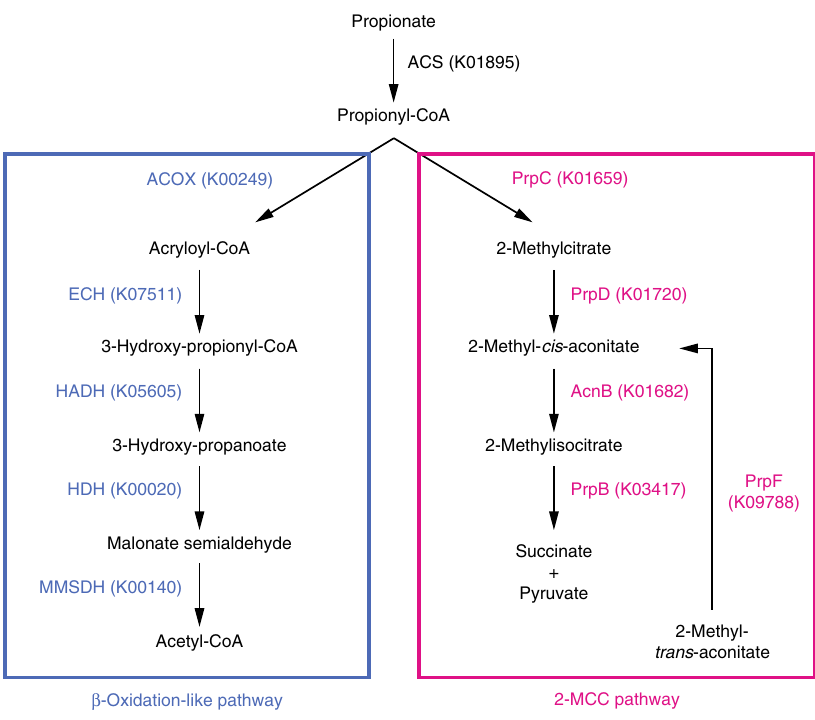
Fig. 6 Chloropicon proteins predicted to participate in the degradation of propionate via the modi fi ed β -oxidation and 2-MCC pathways. Supplementary Data 15 report the loci of the encoding genes, the presence/absence of homologs in other green algae and additional information, including expression data and predicted subcellular localization. PrpC, 2-methylcitrate synthase [EC:2.3.3.5]; PrpD, 2-methylcitrate dehydratase [EC:4.2.1.79]; AcnB, aconitate hydratase 2/2-methylisocitrate dehydratase [EC:4.2.1.99]; PrpB, methylisocitrate lyase [EC:4.1.3.30]; PrpF, 2-methylaconitate cis-trans